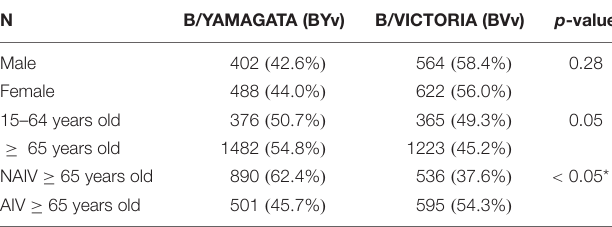
TABLE 1 | Description of the distribution of the different groups